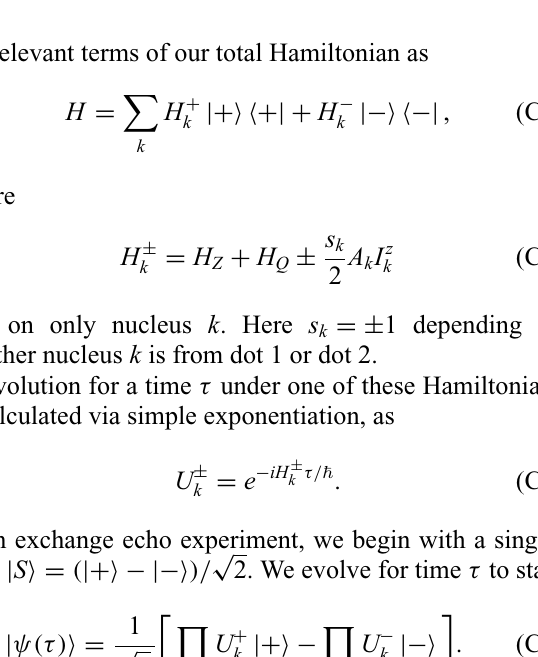
FIG. 11. Free induction decay versus magnetic field. (a) FID decay in the time domain, showing sinusoidal variation under a Gaus- sian envelope as in Eq. (3). (b) Fourier transform of (a), showing that the frequency of the singlet-triplet oscillations increase with applied field in two varying regimes. Note that the applied field is taken from a calibration of the current in the power supply of the superconducting solenoid, which typically carries a few-millitesla offset from true zero field, evident in this